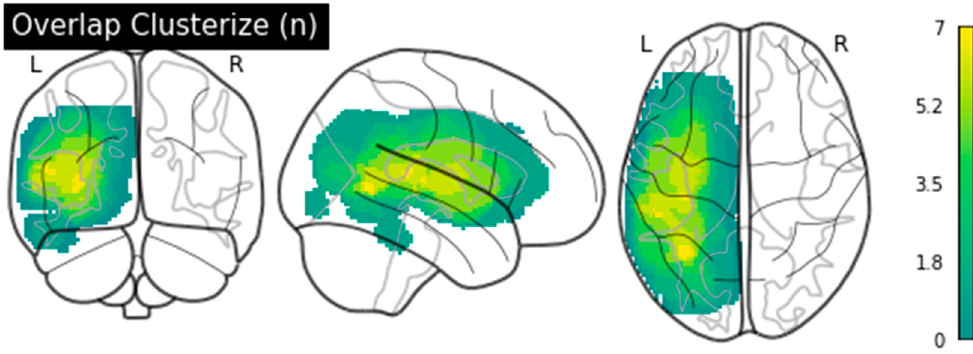
Figure 1. Participants’ lesion distribution in a glass brain. Color coding reflects the number of patients (1–7) with lesion overlap.